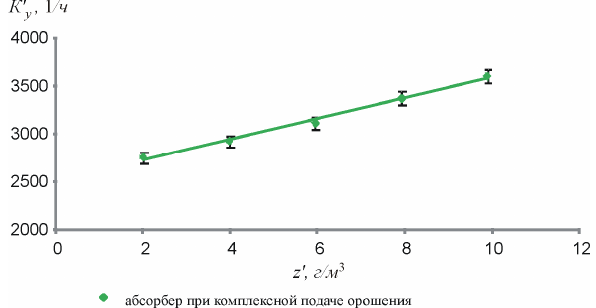
Fig. 7. Dependence of notional volume ratio of absorption on specific irrigation under various types of sprinkling supply ( g ν = 1.37 m/s)